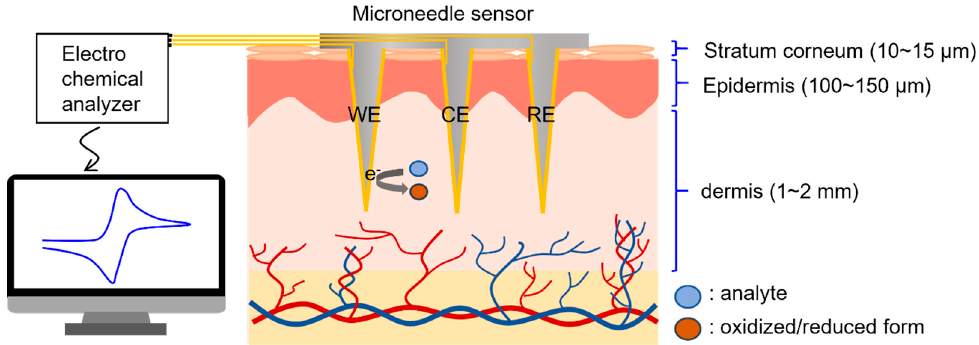
Figure 1. Illustration of the electrochemical detection of biomarkers in dermal interstitial